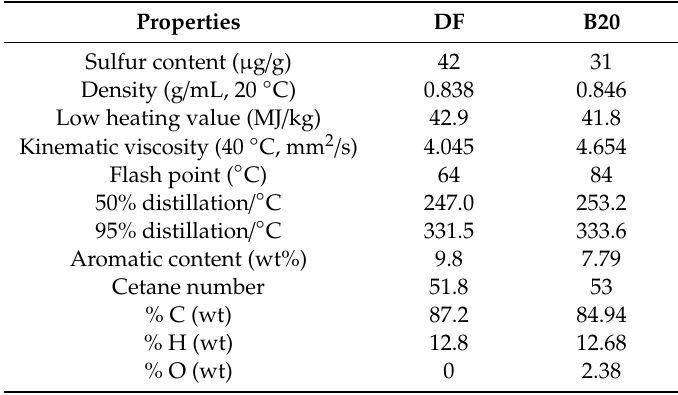
Table 2. Properties of test fuels.